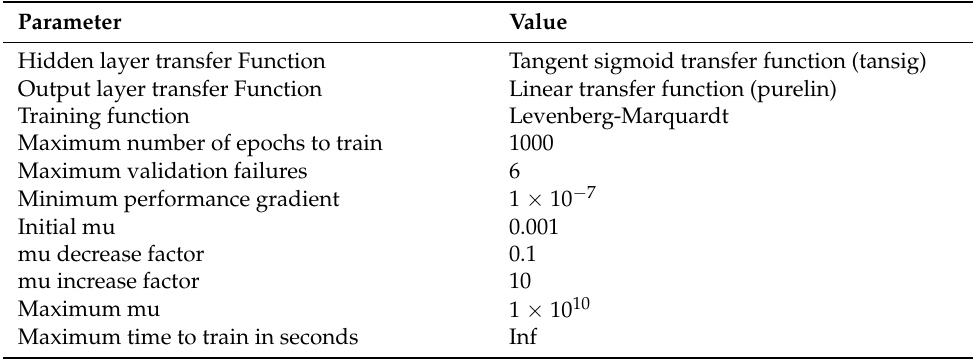
Table 3. Parameters used for FFNN with one hidden layer.